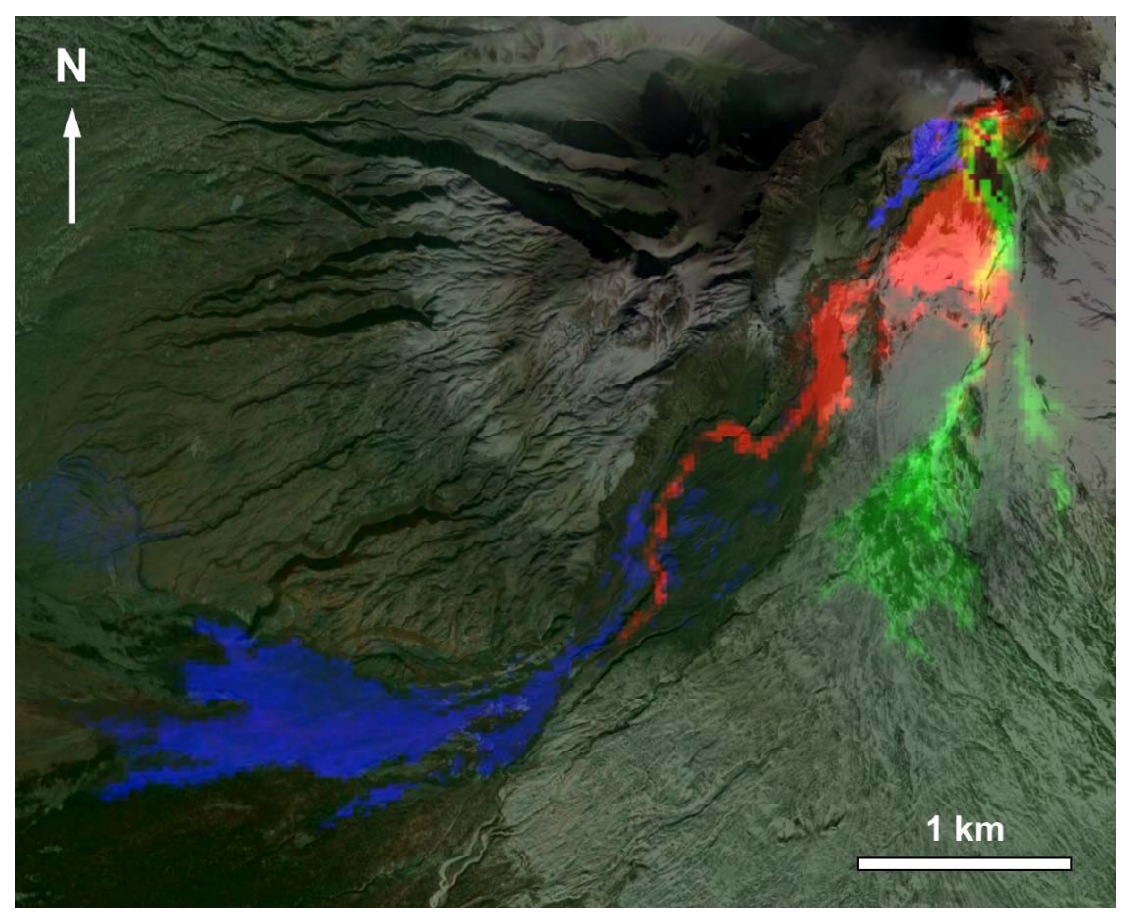
Figure 2. ASTER multi-temporal temperature image composite from 19 May 2001 (red), 11 May 2004 (green), and 29 March 2005 (blue) that highlights the extent (area) and magnitude (intensity of the colour) of the warm deposits. These deposits were generated by the explosive eruptions on 19 May 2001, 9 May 2004, and 28 February